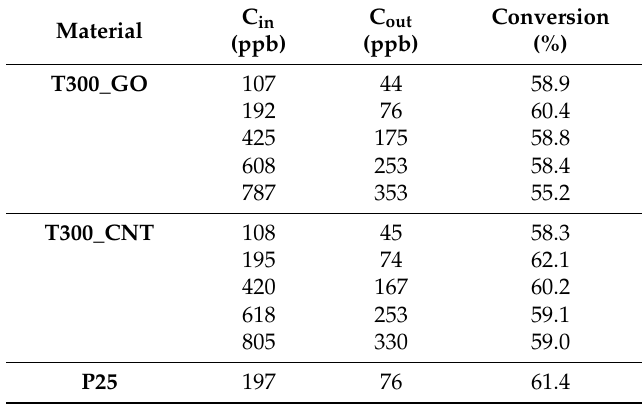
Table 1. Set up conditions and the conversion yield of NO x